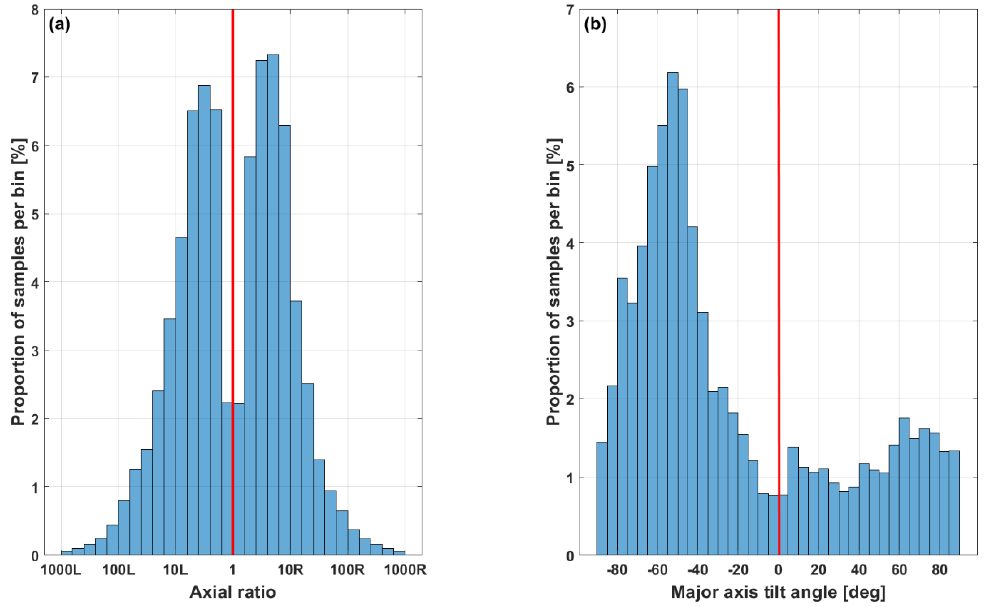
Figure 6. Faroe Islands: 8 August 2018, total 40 min at 6000 samples s − 1 . ( a ) Axial ratio histogram. Horizontal axis: axial ratio (logarithmic scale). Red center line: axial ratio = 1 (circular polarization). Left of center line: left ‐ hand elliptical polarization. Right of center line: right ‐ hand elliptical polarization. Vertical axis: proportion of samples per bin. ( b ) Tilt angle histogram. Horizontal axis: tilt angle (linear scale). Red center line: tilt angle = 0° (horizontal). Left of center line: negative tilt angle. Right of center line: positive tilt angle. Vertical axis: proportion of samples per bin.